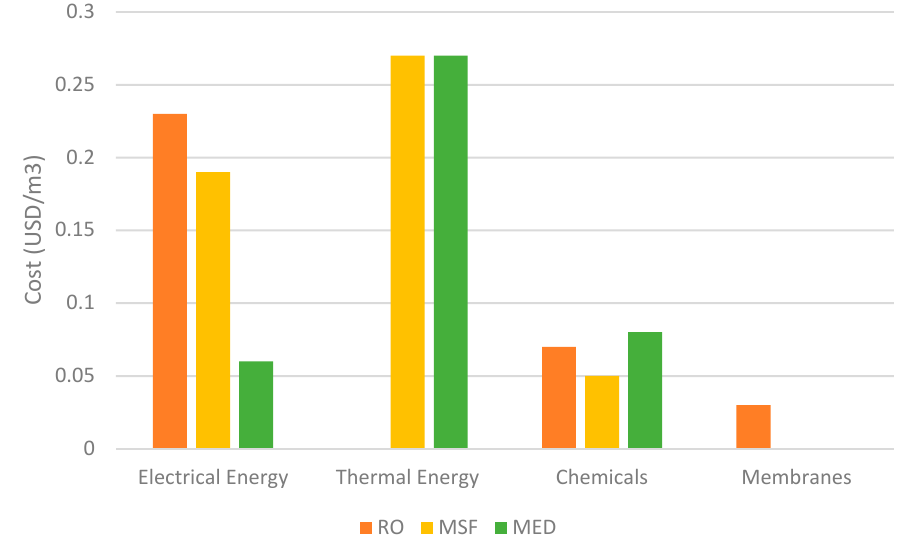
Figure 6. Desalination methods application.